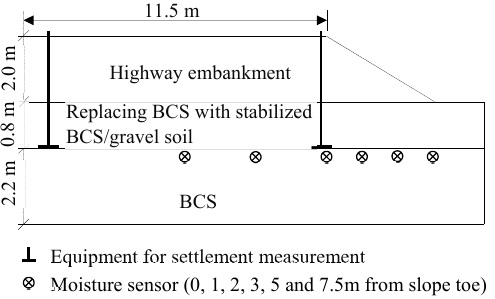
Figure 10. Schematic diagram of the field test replacing BCS with 3% lime + 15% VA-stabilized BCS/gravel soil.